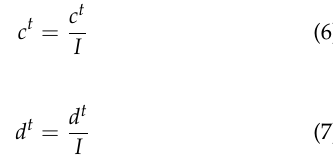
Fig. 3. The flowchart of the ALO algorithm